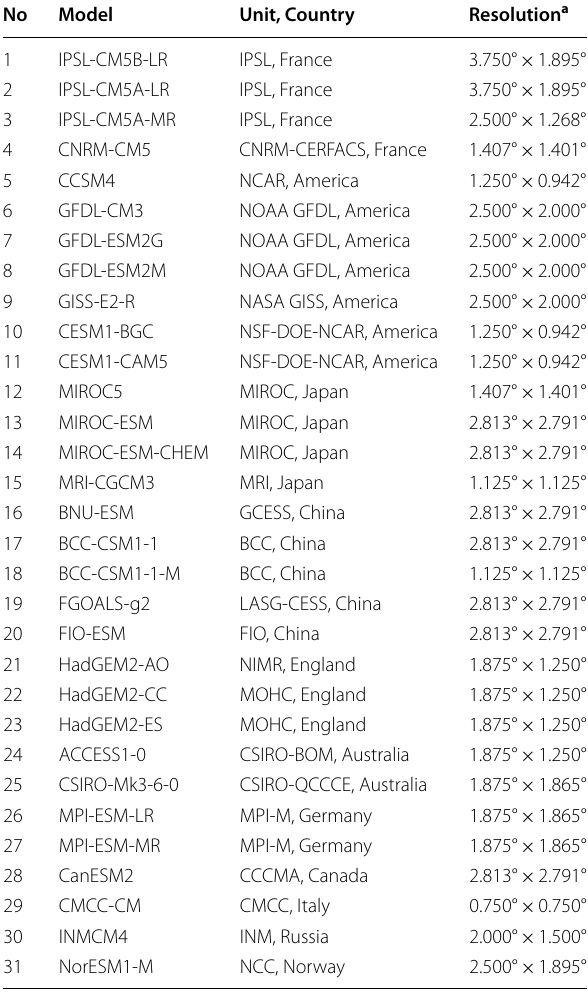
Table 1 Summary of the 31 climate models from CMIP5 used in this